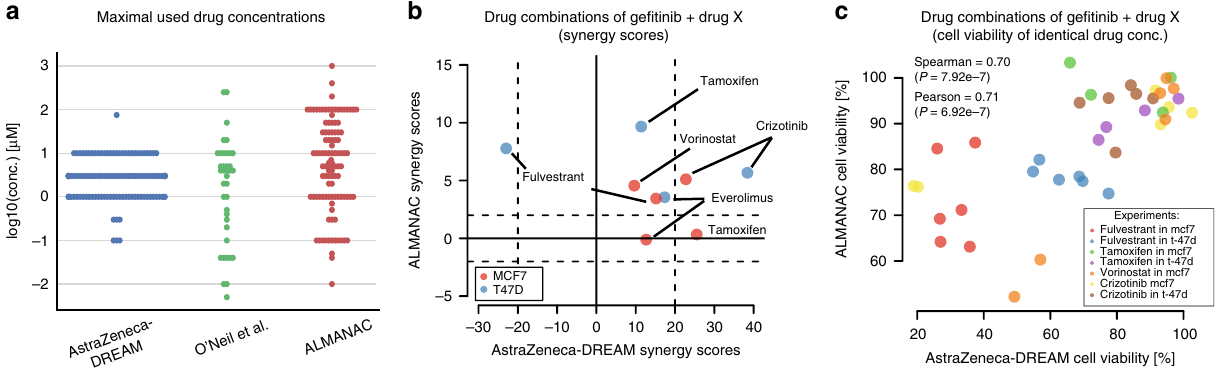
Fig. 2 Reproducibility of independent in vitro drug combination datasets. a Comparison of the maximum drug concentration used in the AZ-DREAM, O ’ Neil et al. 4 and ALMANAC datasets. b Synergy scores of identical drug combinations in AZ-DREAM and ALMANAC. Horizontal and vertical striped lines mark the threshold for synergistic and antagonistic, where positive and negative scores con fi rm synergy and antagonism, respectively. c Shows cell viability for each of the 38 overlapping experimental titration points that are identical in AZ-DREAM and ALMANAC across the nine drug combination experiments, signi fi cance calculated with test for association (Supplementary Fig. 3) For the AZ-DREAM and ALMANAC comparison, only nine in AZ-DREAM and ALMANAC (Fig. 2b). Within the nine experiments passing quality control (Supplementary Methods) overlapping experiments, 38 titrations were identically used by had the same combination tested in the same cell line, comprising both ALMANAC and AZ-DREAM (Supplementary Fig. 3 and ge fi tinib combined with either tamoxifen, fulvestrant, vorinostat, Supplementary Fig. 4a). For these 38 titrations we observed a crizotinib, or everolimus, and tested in two breast cancer cell lines correlation >0.7 (Fig. 2c and P < 10 − 7 , test for association) between cell viability measures from AZ-DREAM and ALMA- (MCF7 or T47D). Encouragingly, all but one experiment were NAC, maintained for individual combinations and cell lines concordantly identi fi ed synergistic with the same effect signs seen NATURE COMMUNICATIONS| (2019) 10:2674